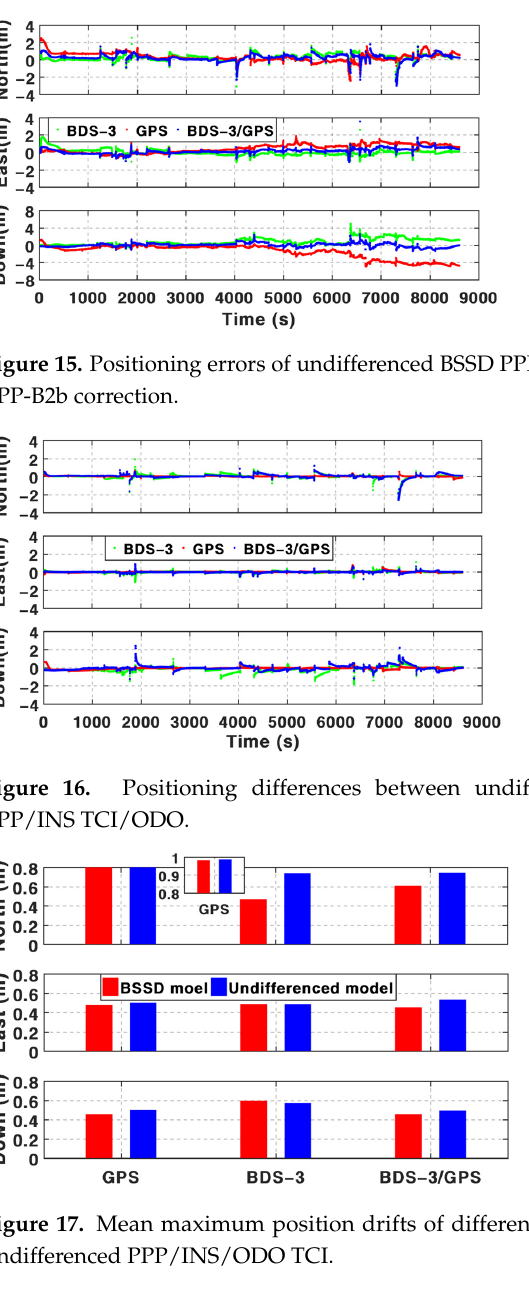
15 of 22 Figure 14. Average maximum position drifts of different GNSS for BSSD PPP/INS TCI ( left ) and